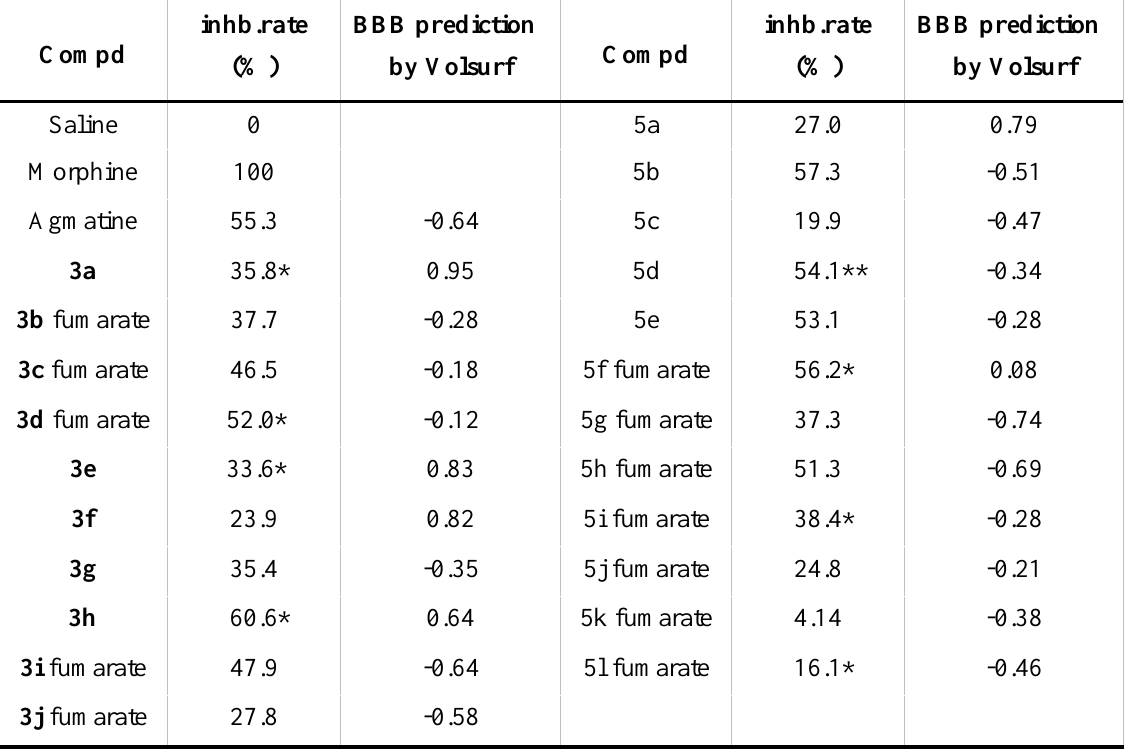
Table 2 . Inhibition on acetic acid-induced mice writhing and BBB profile as predicted by Volsurf. inhb.rate BBB prediction inhb.rate BBB prediction Compd Compd (%) by Volsurf (%) by Volsurf Saline 0 5a 27.0 Morphine 100